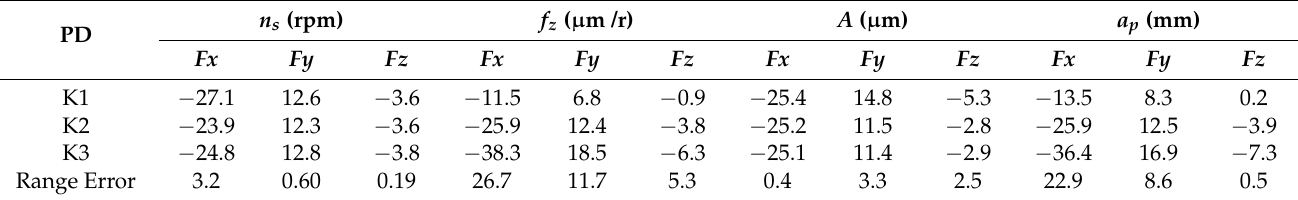
Figure 4. Main effects of various milling parameters on milling forces Fx , Fy and Fz . ( a , e , i ) Effect of spindle speed on milling forces Fx , Fy and Fz under polarization difference analysis; ( b , f , j ) Effect of feeds per tooth on milling forces Fx , Fy and Fz under polarization difference analysis; ( c , g , k ) Effect of ultrasonic amplitude on milling forces Fx , Fy and Fz under polarization difference analysis; ( d , h , l ) Effect of ultrasonic cutting depth on milling forces Fx , Fy and Fz under polarization difference analysis. Table 5. Analysis of the influence of milling